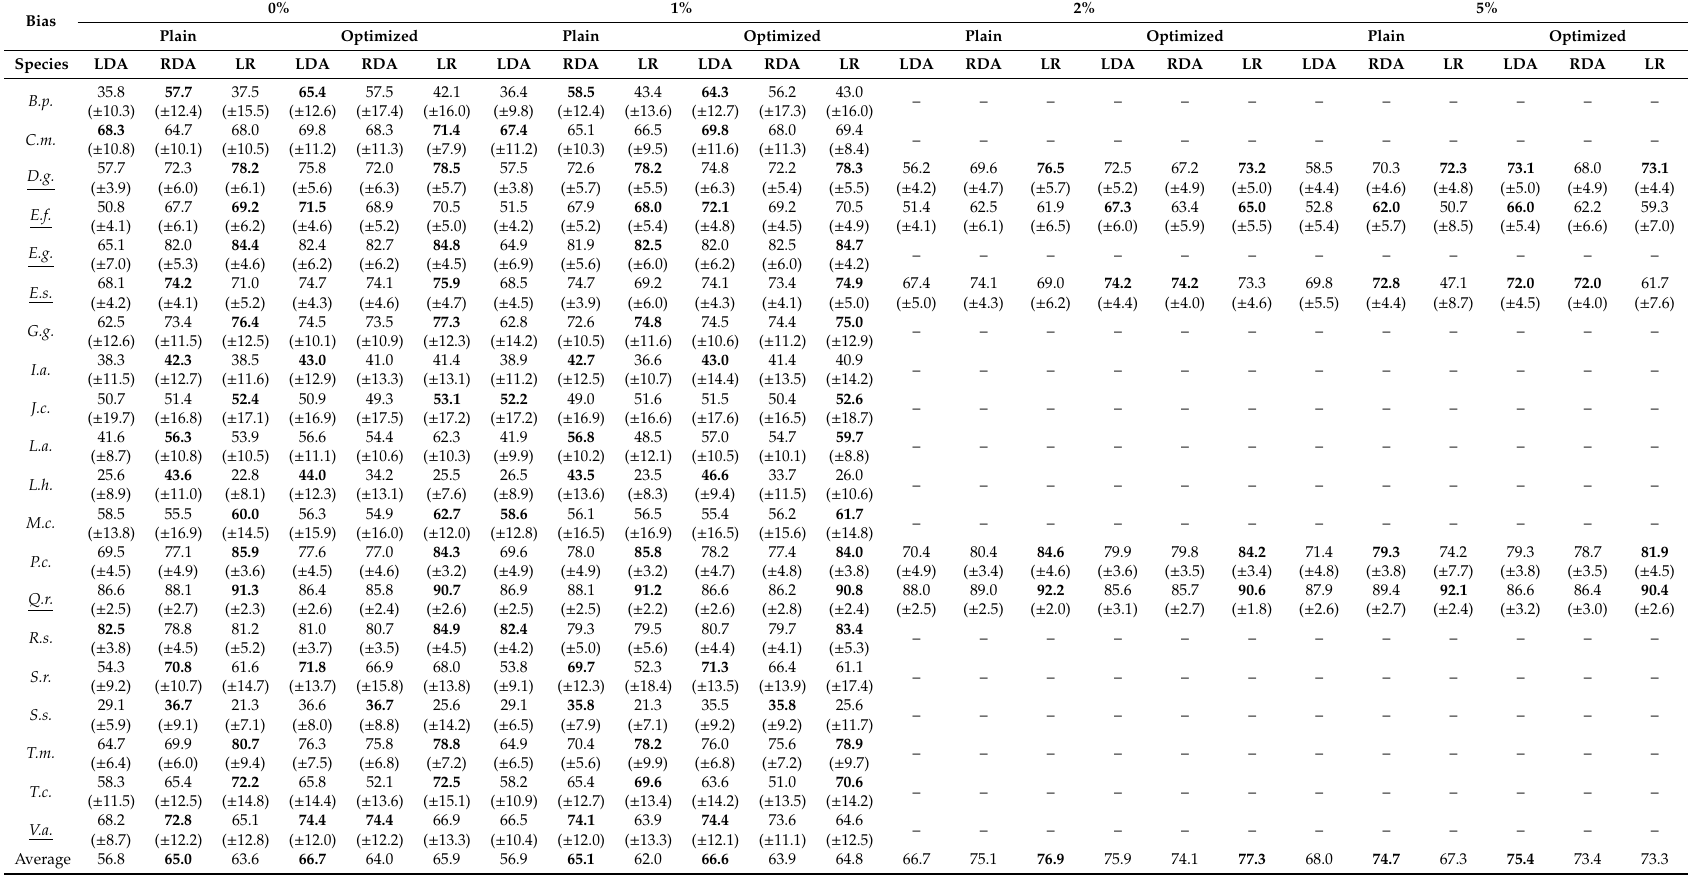
Table A2. Full table for the comparison between methods and bias applied, with and without optimisation step. Plain and optimized indicate whether an optimization step (selecting a threshold probability value) was applied to maximize either the F measure (0% contamination) or the Lee and Liu 2003 criterion (1% contamination). The F-measure is given at crown scale. The best prediction for each species, configurations and methods is in